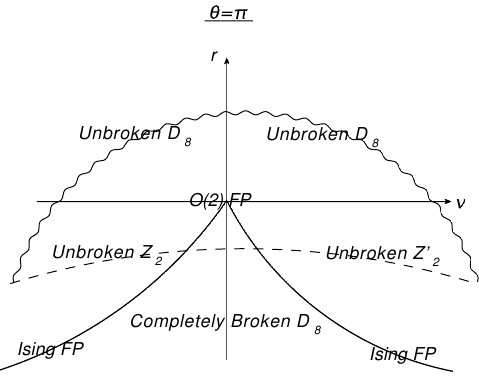
Figure 8 . The phase diagram of (6.1). Changing the temperature β − 1 with fixed θ = π in the gauge theory is a line in this diagram starting at the lower left side and ending in the lower right side. The dashed line corresponds to the scenario in section 5 with figure 4, and the wiggly line corresponds to the scenario in section 6 with figure